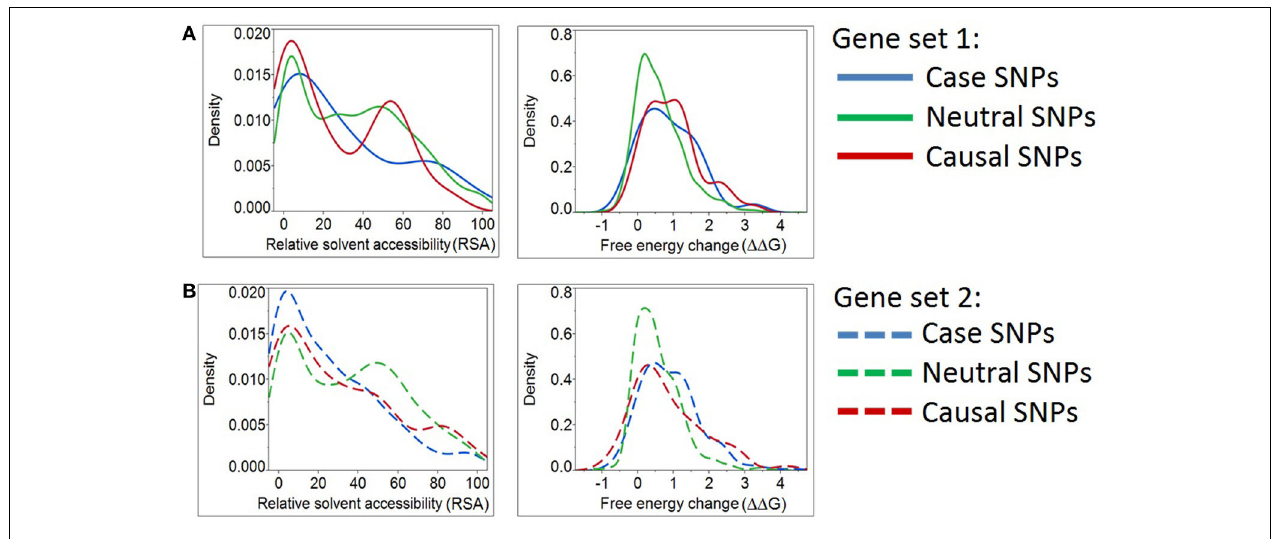
FIGURE 3 | Density plots for relative solvent accessibility and free energy change for Case, Neutral, and Causal SNPs. The two structure-based scores demonstrate that Case and Causal SNPs share similar